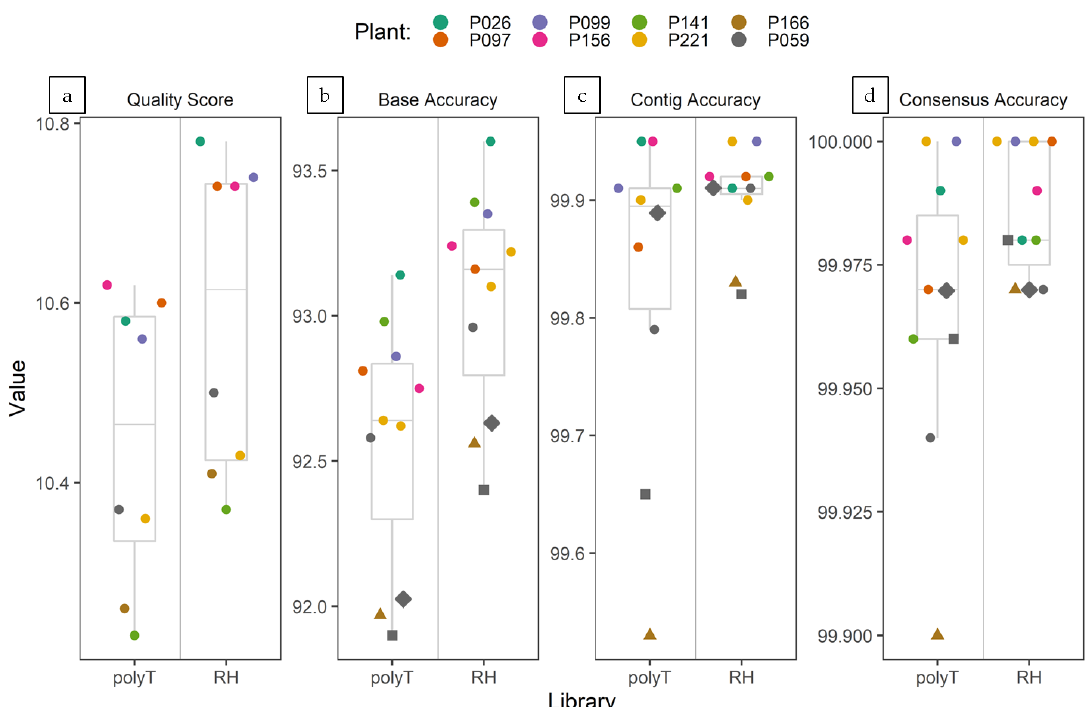
Figure 3. Box plots depicting quality score ( a ) and accuracy of ONT reads ( b ), contigs ( c ) and consensus sequences ( d ) generated from the PolyT- and random hexamers-primed libraries. The lower and upper hinges correspond to the first and third quartiles; the upper whisker extends from the hinge to the largest value no further than 1.5 * IQR from the hinge (where IQR is the inter-quartile range). The lower whisker extends from the hinge to the smallest value at most 1.5 * IQR of the hinge. For clarity of display, the y axis on each graph was scaled accordingly. ( a ) Quality score as calculated by the EPI2ME online platform. ( b ) Accuracy of ONT virus-related reads as percentage of matches over the coverage at each nt position. ( c ) Percent identity of ONT-derived viral contigs compared to the correspondent Illumina consensus. ( d ) Percent identity of ONT-derived viral consensus sequences compared to the correspondent Illumina consensus. In 3b, 3c and 3d dots refer to PVY, triangles to PLRV, squares to PVS and diamonds to